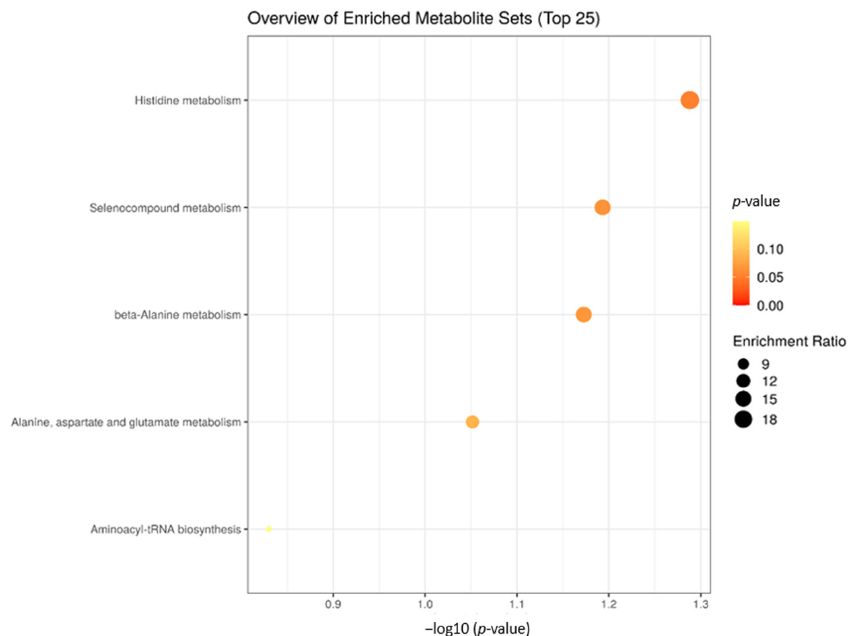
Figure 6. Biological processes involved with significant plasma metabolites of calves at 30 days of age submitted to the three prenatal nutritional treatments (NP, PP and FP).